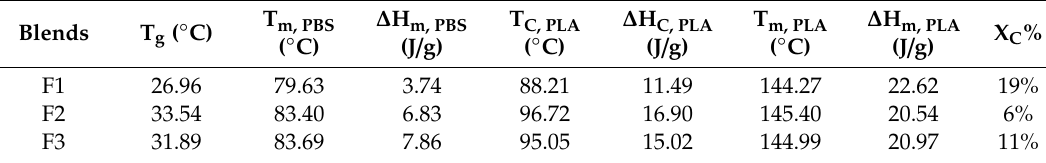
Table 7. Results of DSC analysis (second heating).